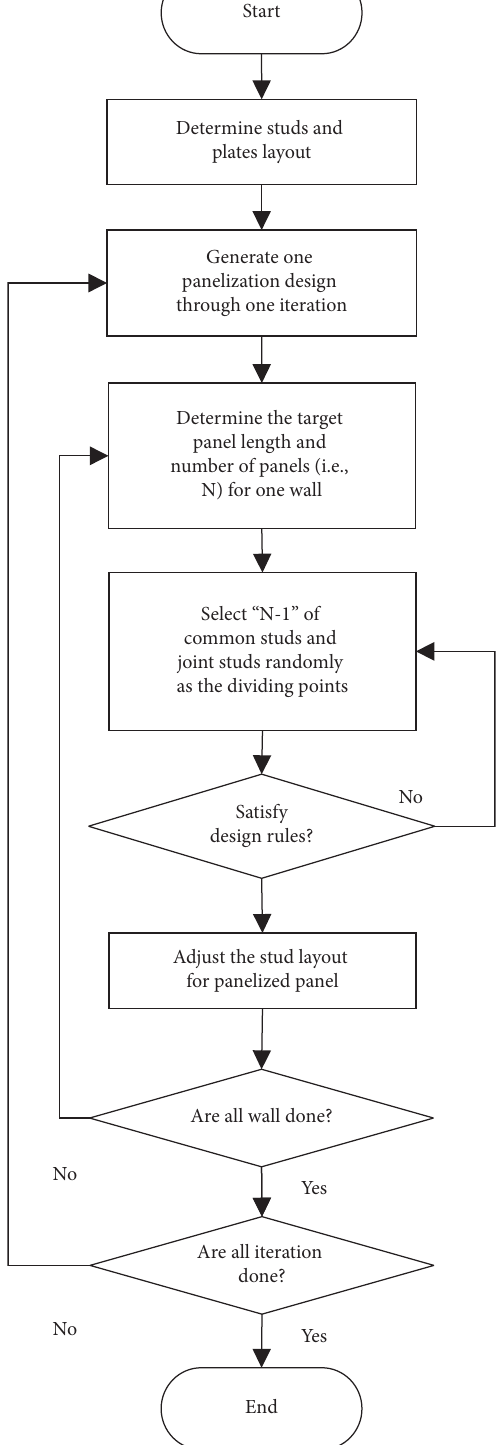
Figure 4: Wall panelization design